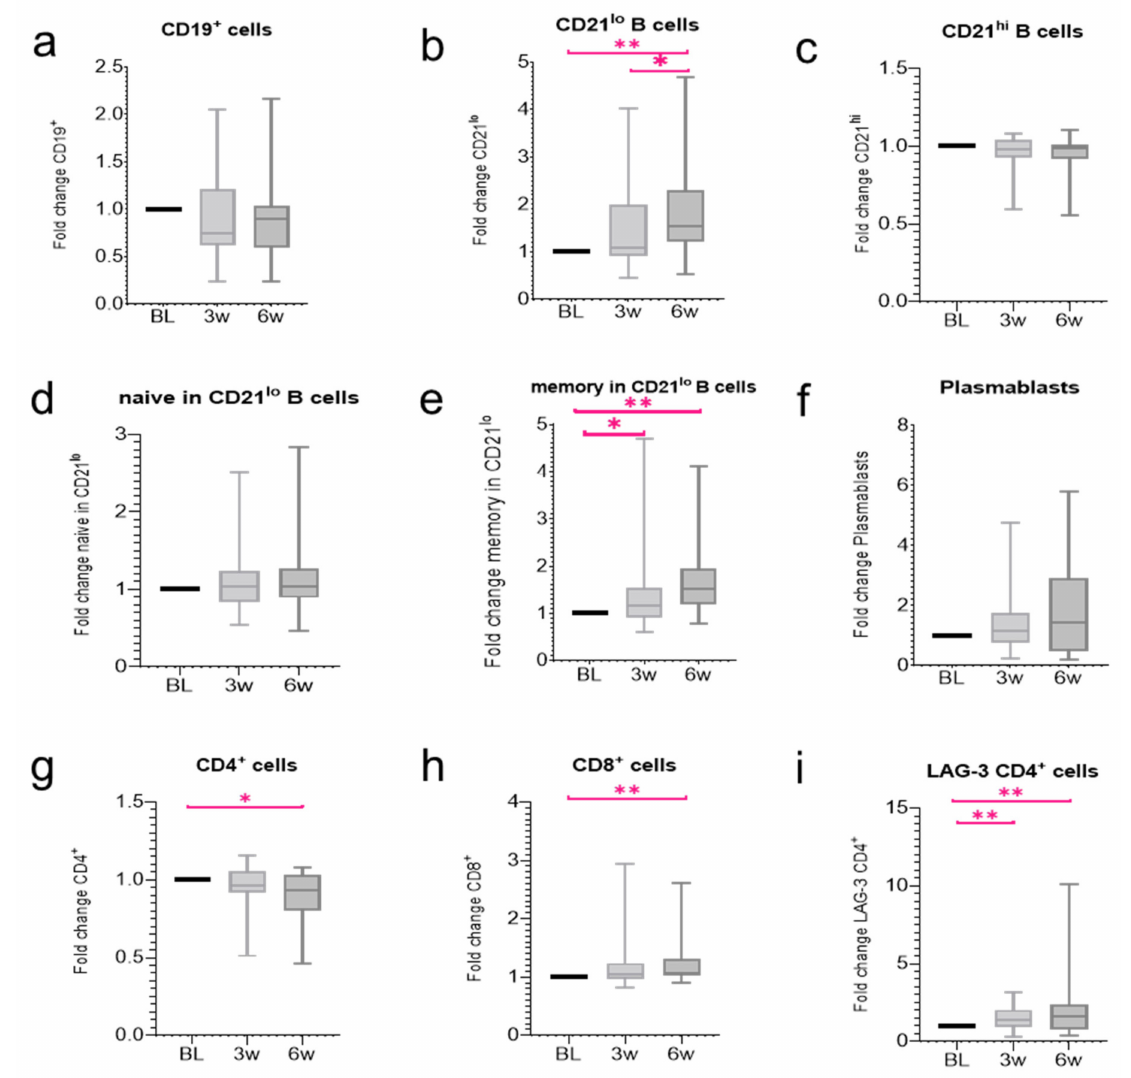
Figure 1. Changes in the proportion of the peripheral blood cells after combination checkpoint blockade (CCB) therapy. The box plot shows the fold change in the proportion of cells compared with baseline (BL) as well as 3 and 6 weeks after therapy. Changes in the proportion of ( a ) circulating B cells, ( b ) CD21 lo B cells, ( c ) CD21 hi B cells, ( d ) CD21 lo naïve B cells, ( e ) CD21 lo memory B cells, ( f ) plasmablasts, ( g ) circulating CD4 + cells, ( h ) CD8 + cells, and ( i ) LAG-3 CD4 + cells. All data represent the mean ± standard error of mean (SEM). * p < 0.05 and ** p < 0.01 by two-tailed Wilcoxon signed-rank